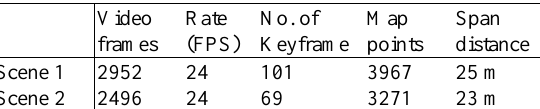
Table 1. Statistics of the test